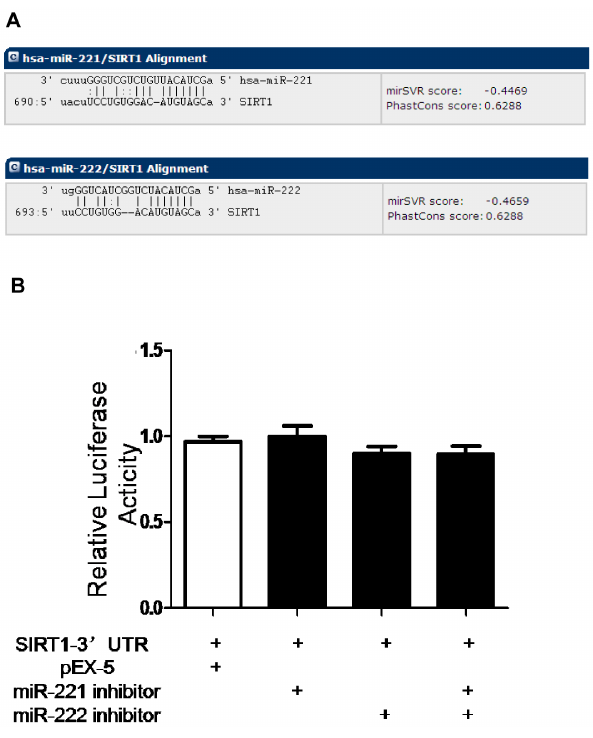
Figure 10. Regulation of SIRT1 by miR-221 and miR-222. ( A ) The complementary binding sites of miR-221 and miR-222 on SIRT1-3 9 UTR predicted by miRanda database. ( B ) Luciferase activity was carried out to verify the binding and interaction of miR-221 and miR-222 with SIRT1. There were no differences in luciferase activity among the groups (P . 0.05). Data represent the mean value 6 SEM from three separate experiments.